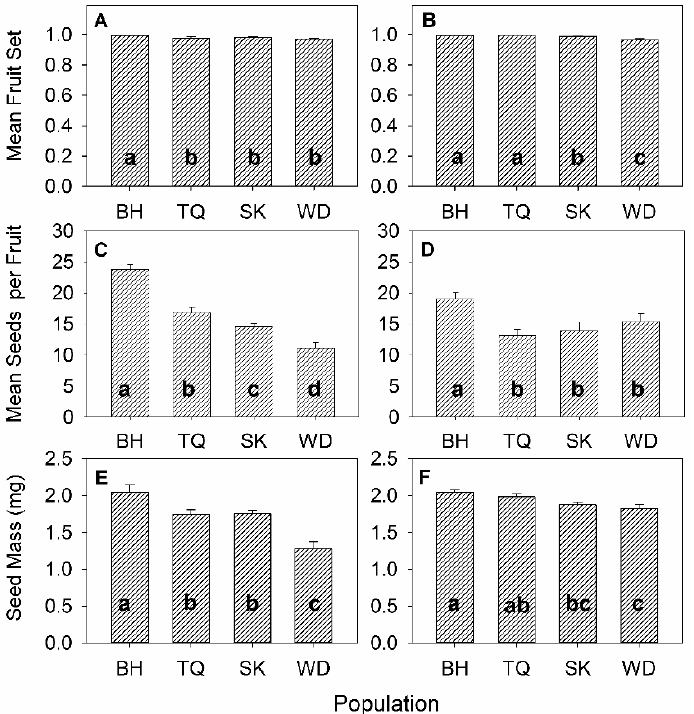
Figure 3. Mean fruit set ( A , B ), filled seeds per fruit ( C , D ), and seed mass ( E , F ) for plants from four dwarf bear poppy populations in 2019 (panels A , C , E ) and 2020 (panels B , D , F ). Within a reproductive component and year, bars with the same letter are not significantly different at p < 0.05. BH = Beehive Dome, TQ = Tonaquint, SK = Shinob Kibe, WD = White Dome. See Appendix A for full statistical analysis.